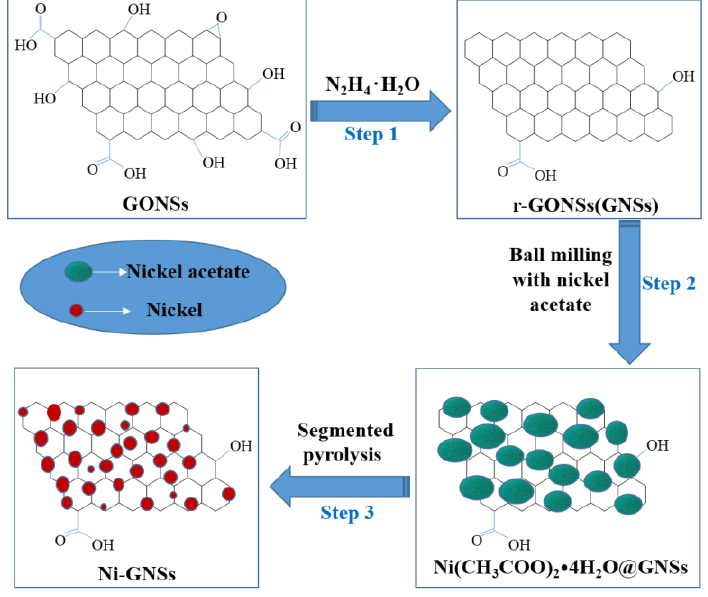
Figure 1. Schematic of preparation of Ni-modified graphene nanosheets (GNSs).